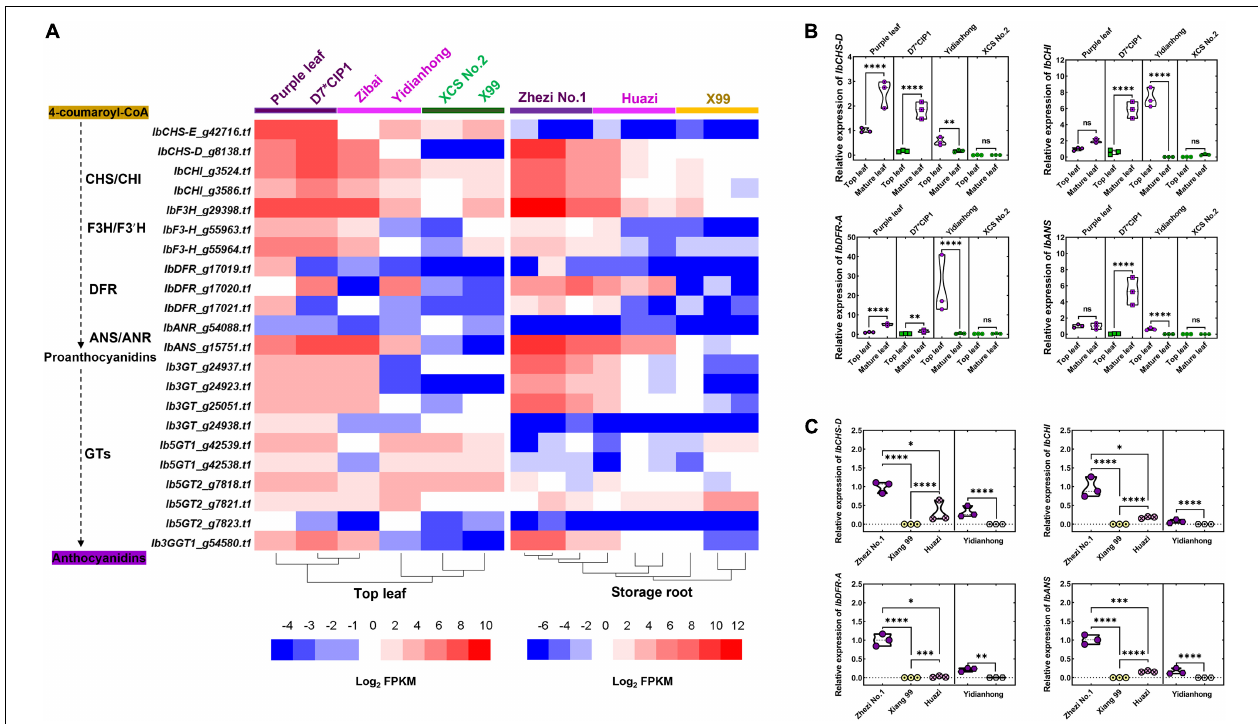
FIGURE 2 | Gene expression difference of enzyme-coding genes related to anthocyanin biosynthesis. (A) Heatmap of differentially expressed genes (DEGs) related to enzyme-coding genes in leaf and storage root by RNA sequencing (RNA-Seq). The color of the variety name and the lower horizontal line represents the color of the sample. (B) Enzyme-coding gene expression comparisons between top leaf and mature leaf of varieties by RT-qPCR. (C) Enzyme-coding gene expression comparisons between different colors of flesh by RT-qPCR. The purple flesh of “Yidianhong” and the non-purple flesh of “Yidianhong” were analyzed. The color of jitter in the violin plot represents the color of the corresponding sample. * P < 0.0332, ** P < 0.0021, *** P < 0.0002, and **** P < 0.0001; ns indicates P > 0.1234. n = 3.